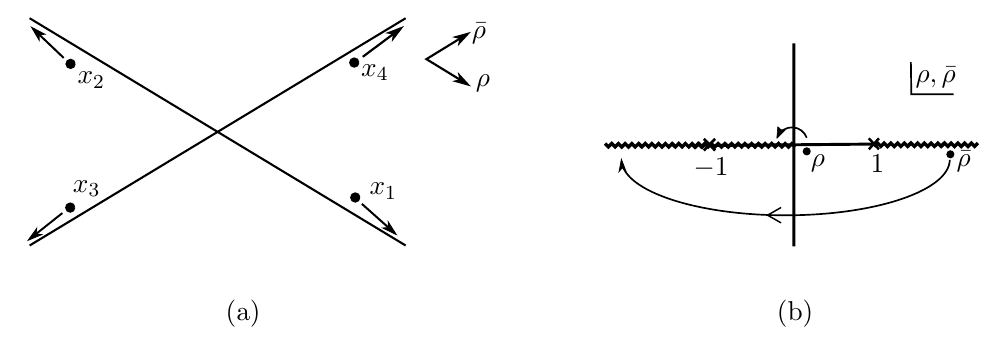
Figure 3 . (a) Correlator in the Regge limit (cid:26) / 1 =E ! 0, (cid:22) (cid:26) / E ! 1 (with an overall boost applied to (cid:12)gure 2 to make the (cid:12)gure more symmetrical). (b) The crossing symmetry path E ! Ee (cid:0) i(cid:25) , which interchanges points 3 and